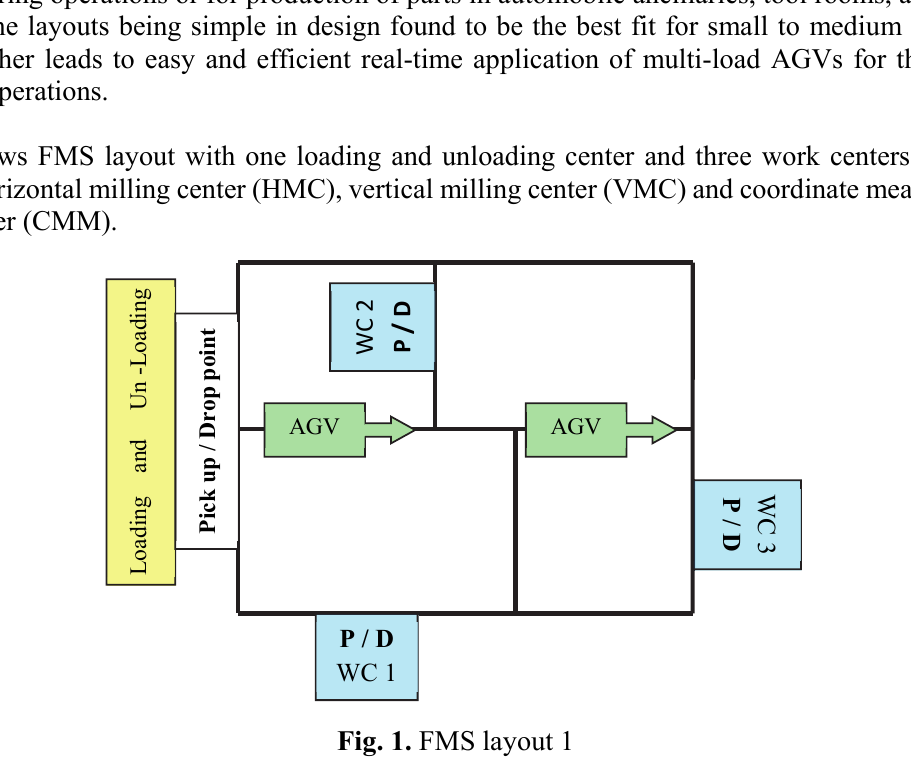
Fig. 2 represents FMS layout with one loading and unloading center and six work centers namely hor- izontal milling center (HMC), vertical milling center (VMC), de-burring center, welding center, paint- ing, and coating center and coordinate measuring machine center (CMM)